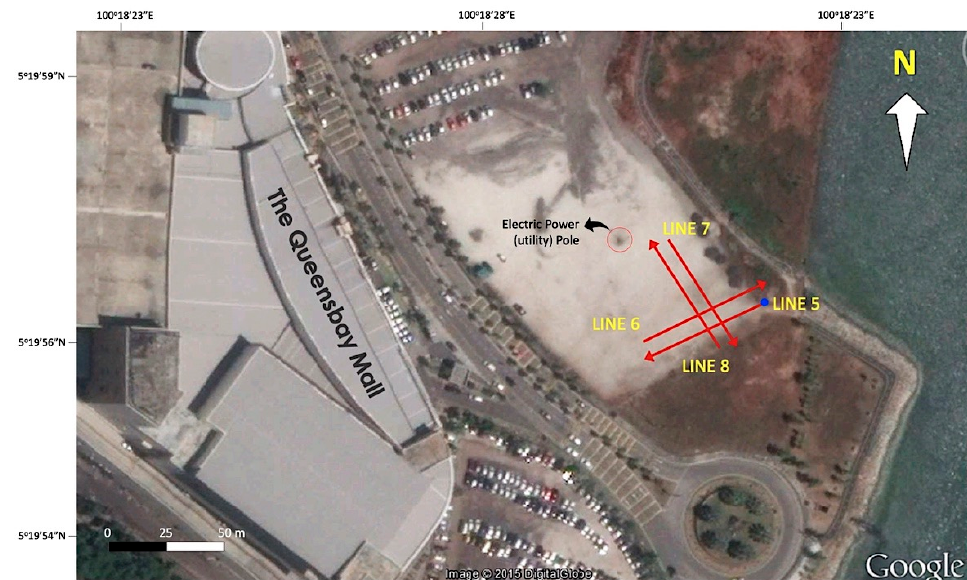
Figure 2. Survey lines of GPR at site 1, Batu Ferringhi, representing natural coastal landform, plot- ted on Google Earth (2015), Batu Ferringhi, Penang, Malaysia. The coordinates for the initial point of survey lines ( • ) is 05°28 ′ 17.24 ″ N and 100°14 ′ 39.00 ″ E. DigitalGlobe 2015. http://earth.google.com (accessed on 3 February 2015).